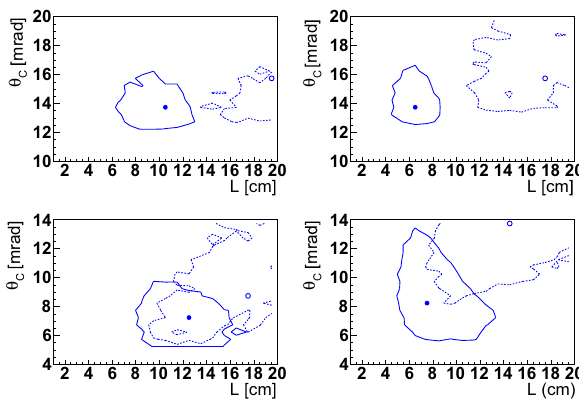
Fig. 9 Distribution of polar angle θ y versus momentum for Λ + c baryons produced in 7TeV proton beam collisions on protons at rest using Pythia